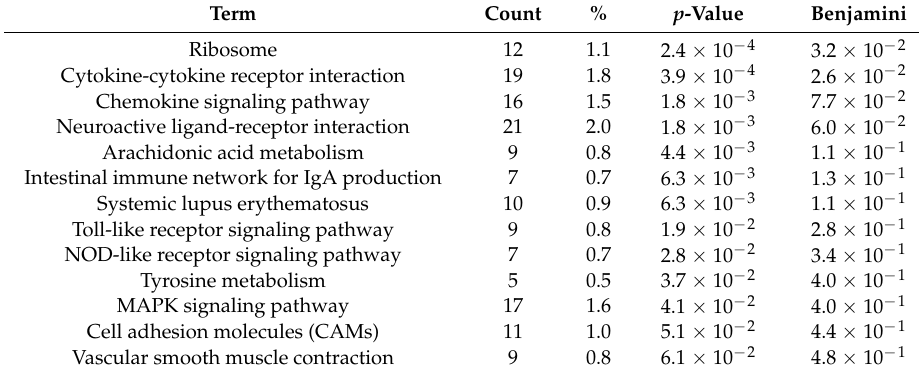
Table 3. Significantly regulated KEGG pathways in the developing kidney treated with ADMA versus